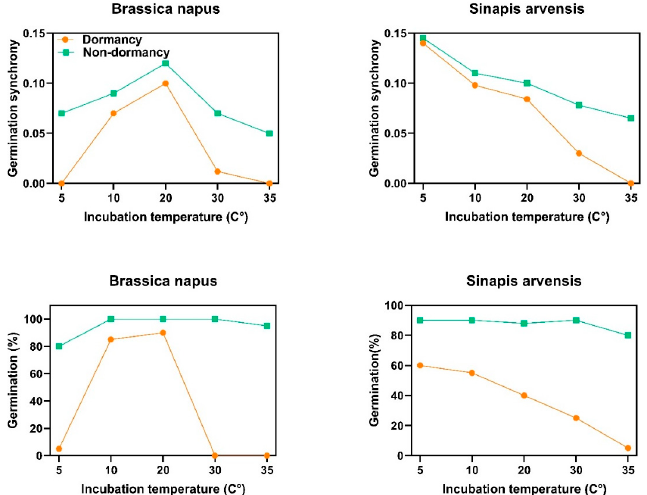
Figure 4. Germination behavior and synchrony patterns of two species of Brassicaceae family at different incubation temperatures. Brassica napus and Sinapis arvensis have type 3 and 1 non-deep physiological dormancy, respectively. To obtain nondormant seeds, after-ripening was applied as a dormancy-breaking agent.